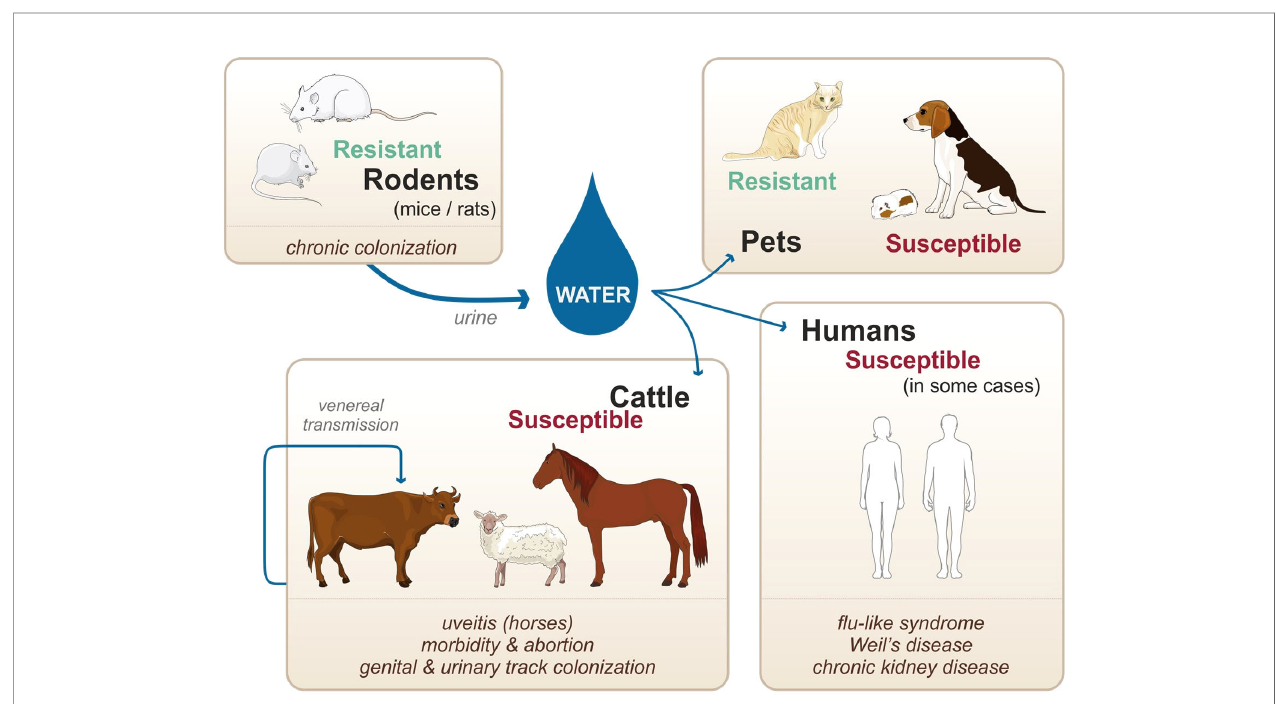
FIGURE 1 | Zoonotic cycle of leptospirosis, susceptibility of various accidental hosts, and transmission modes. Adapted from Adler,